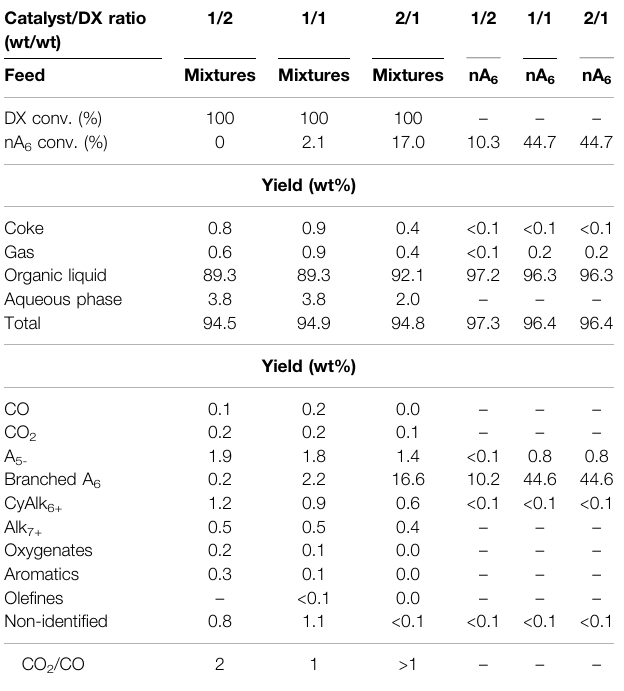
TABLE 4 | Effect of catalyst/DX ratio on DX HDO product distribution and yield (wt%). General reaction conditions: 250 ° C; 30 bar of H 2 ; 12 h; 90 g n-hexane; catalyst/DX ratio (wt.): 1/2 (cid:1) 5 g Cat/10 g DX; 1/1 (cid:1) 10 g Cat/10 g DX; 2/1 (cid:1) 10 g Cat/5 g DX. Catalyst/DX ratio (wt/wt)